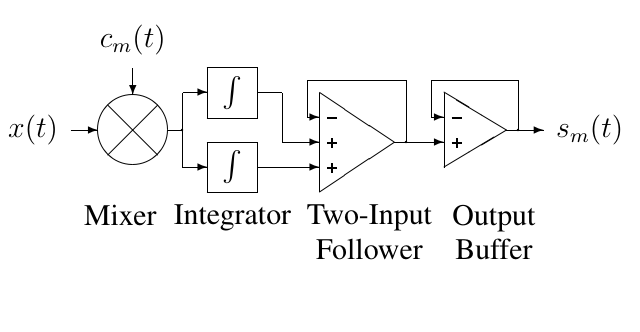
Figure 5. Channel component block diagram.